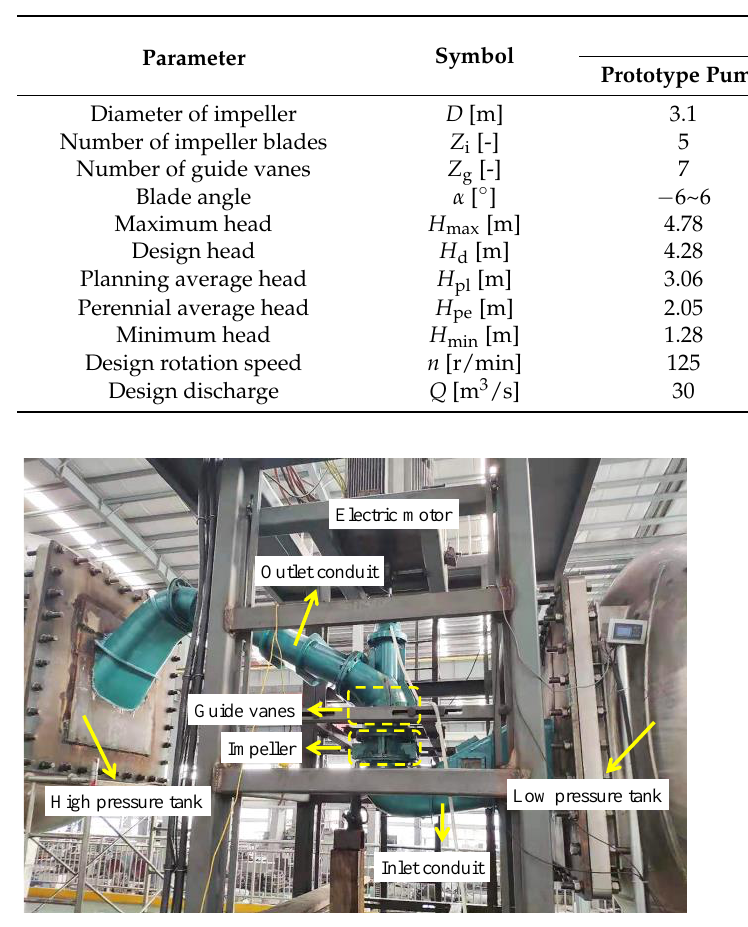
Table 1. Characteristic parameters of the axial flow pump system.